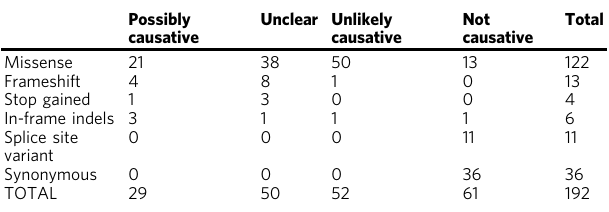
Table 1 De novo mutation classi fi cation summary.